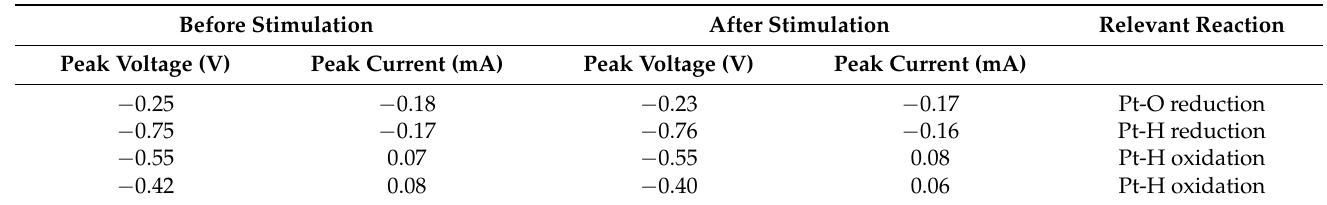
Table 4. CV faradaic peaks and associated electrochemical reactions before and after long-term electrochemical testing.